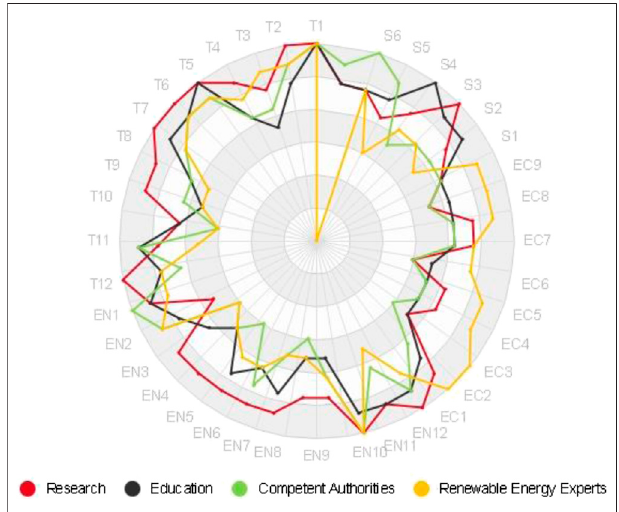
FIGURE 4 | Criteria ranking summary by experts ’